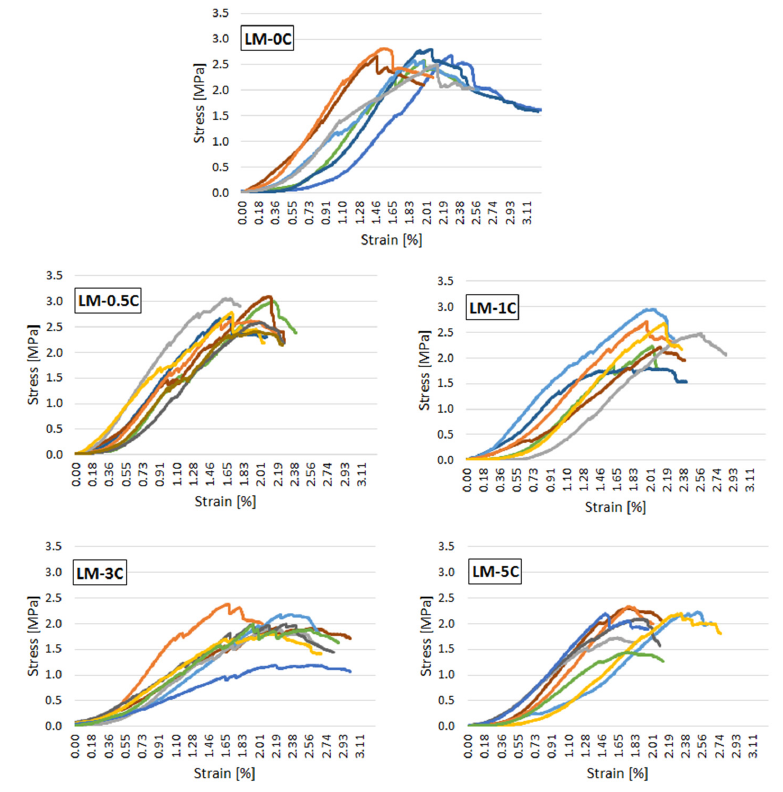
Figure 7. The dependence of the bending force on the press head displacement. Figure 7. Stress–strain relationship for the tested The results of the flexural and compressive strength tests are shown in Figure 8. Error bars depict standard deviation.